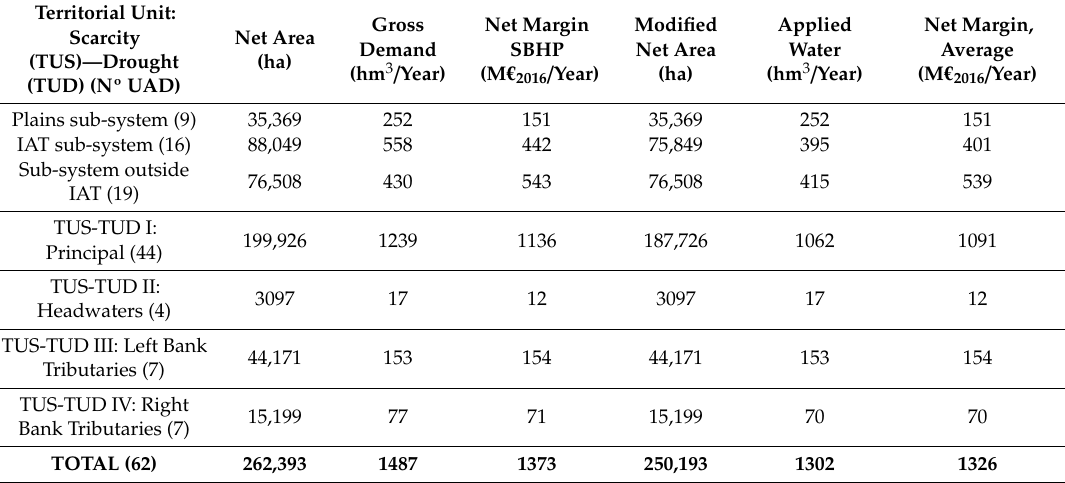
Table 5. Net margin SBHP 2015 / 21 and average. Source: SBHP 2015 / 21. Own